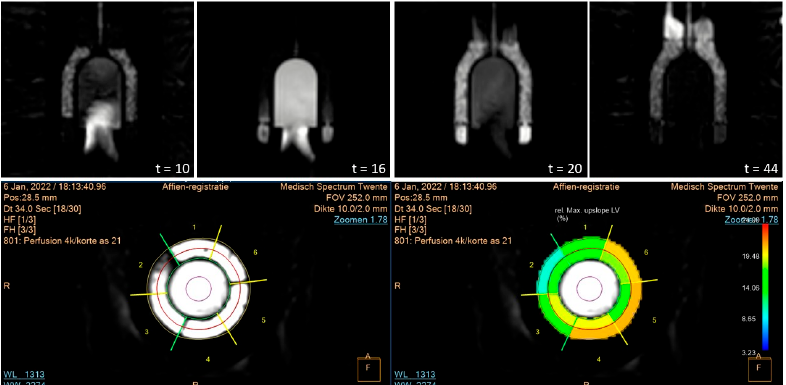
Figure 6. Example of MR myocardial perfusion image analysis. ( Top ) visualization of a time-lapse across a longitudinal heart axis plane showing contrast arrival and distribution in the mimicked left ventricular cavity (center) and three surrounding myocardial regions (time in seconds). ( Bottom ) clinical software display of segmental myocardial perfusion analysis. In this, segment 2 depicts a simulated perfusion deficit. The colors indicate the relative maximum upslope of the tissue region as a ratio of the maximum upslope in the left ventricular cavity, scaled from 3.23 to 24.90%. Multimodal TACs/TICs are displayed in Figure 7, highlighting contrast media distribution over time within the mimicked LVC and myocardial tissue regions/segments. Table 2 provides an impression of software derived MBF values (from a single scan) compared to the set reference flow in the phantom setup. Table 2. Impression of software derived myocardial blood flow (MBF) or other perfusion measures from a reference phantom measurement in PET/CT, CT, and MR.